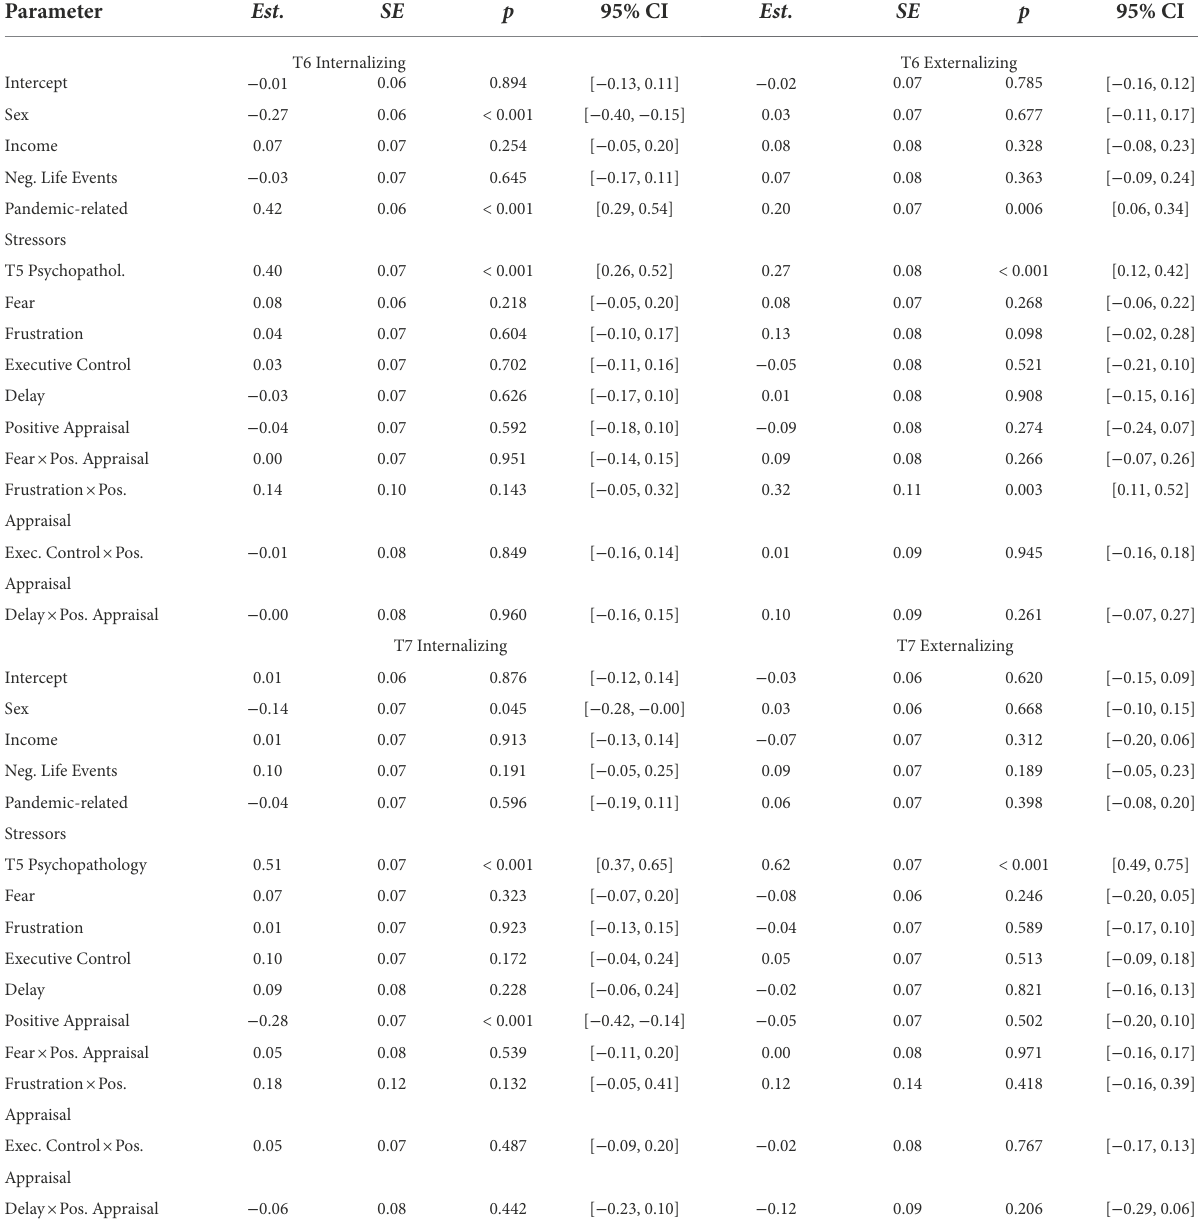
TABLE 5 Standardized regression coefficients, standard errors, and confidence intervals from regressions predicting adolescent psychopathology from temperament and positive appraisal.